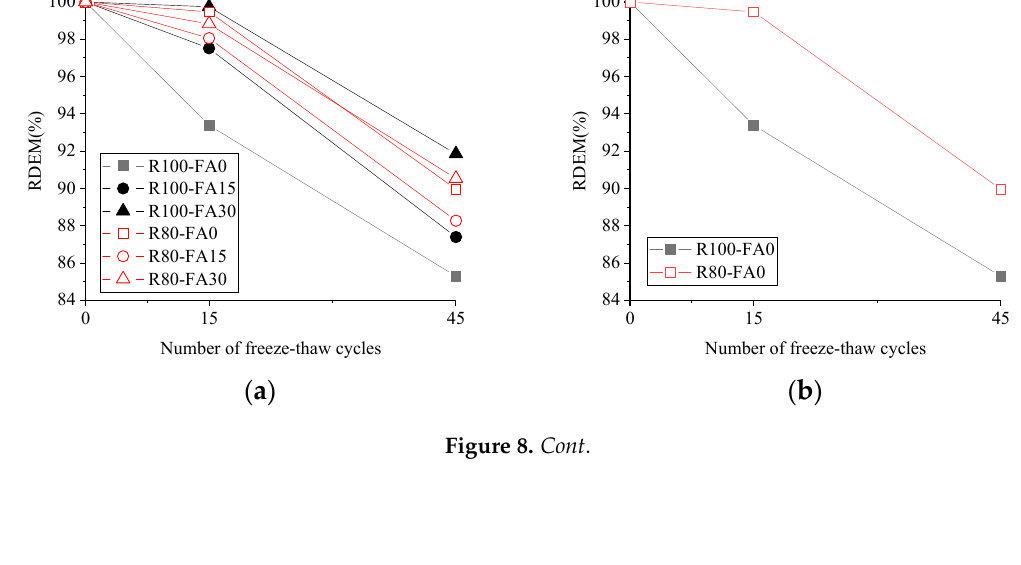
Figure 7. Multifactor influence on the mass loss rate of 3%NS-45FT. Figure 8 illustrates the decline in RDEM of concrete specimens exposed to 3% NS-45FT. All RDEMs exhibited a declining trend, and their amplitudes ranged from 9.58% to 46.92% of their starting value. Furthermore, R100-FA0 had the greatest reduction in RDEM, with a noticeably steep curve and a total RDEM decrement of 53.08%, followed by R100-FA15 and R80-FA15.